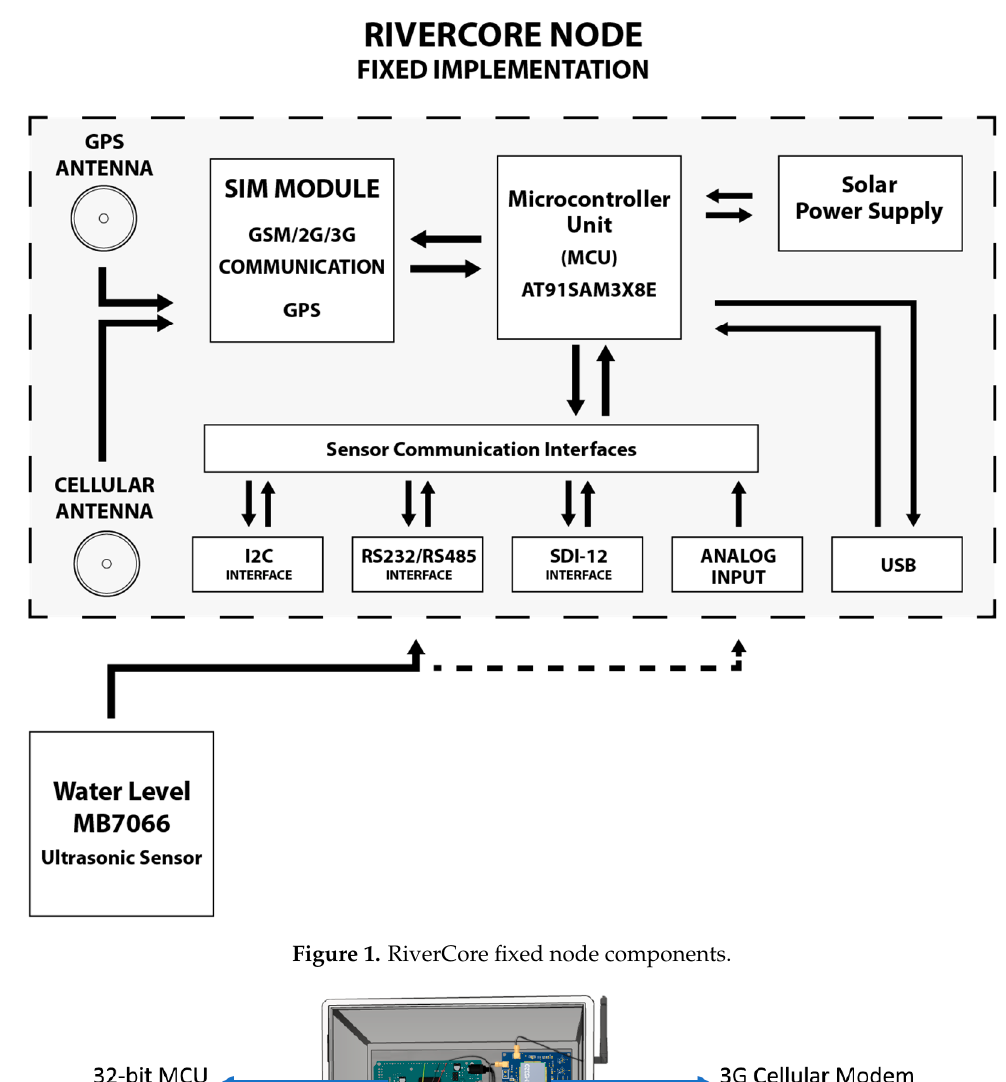
Figure 1. RiverCore fixed node components.